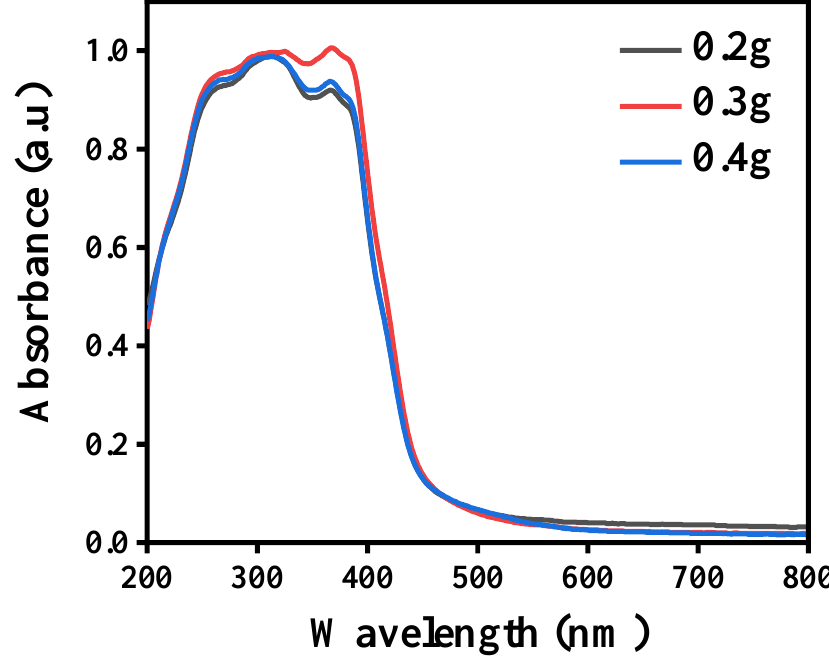
Figure 6. Ultraviolet – visible diffuse reflectance spectroscopy of composites of x g — C 3 N 4 /ZnO. Photodegradation processes of all four samples are calculated under regulated vis- ible light irradiation through oxidation of nitenpyram (NPT), Tetracycline (TC) and sul- famethoxazole (SMZ). Having heterojunctions makes the photodegradation process greatly improved. NPT, TC and SMZ photodegradation proficiency in 0.4 g C 3 N 4 /ZnO is 94.2%, while photocatalytic productivities for pure 0.1 g, 0.2 g and 0.3 g C 3 N 4 /ZnO are 50.1%, 56.1%, and 81.8%, respectively (Figures 7 and 8). Photodegradations of NPT, TC and